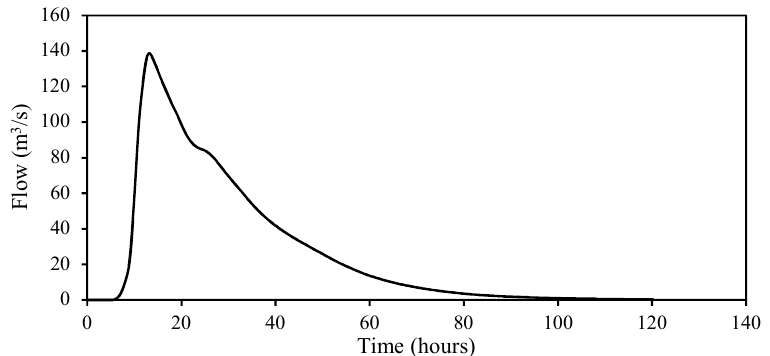
Figure 11. Example of a hydrograph of one of the stochastic scenarios (RCP 4.5, 10-year return pe- riod).